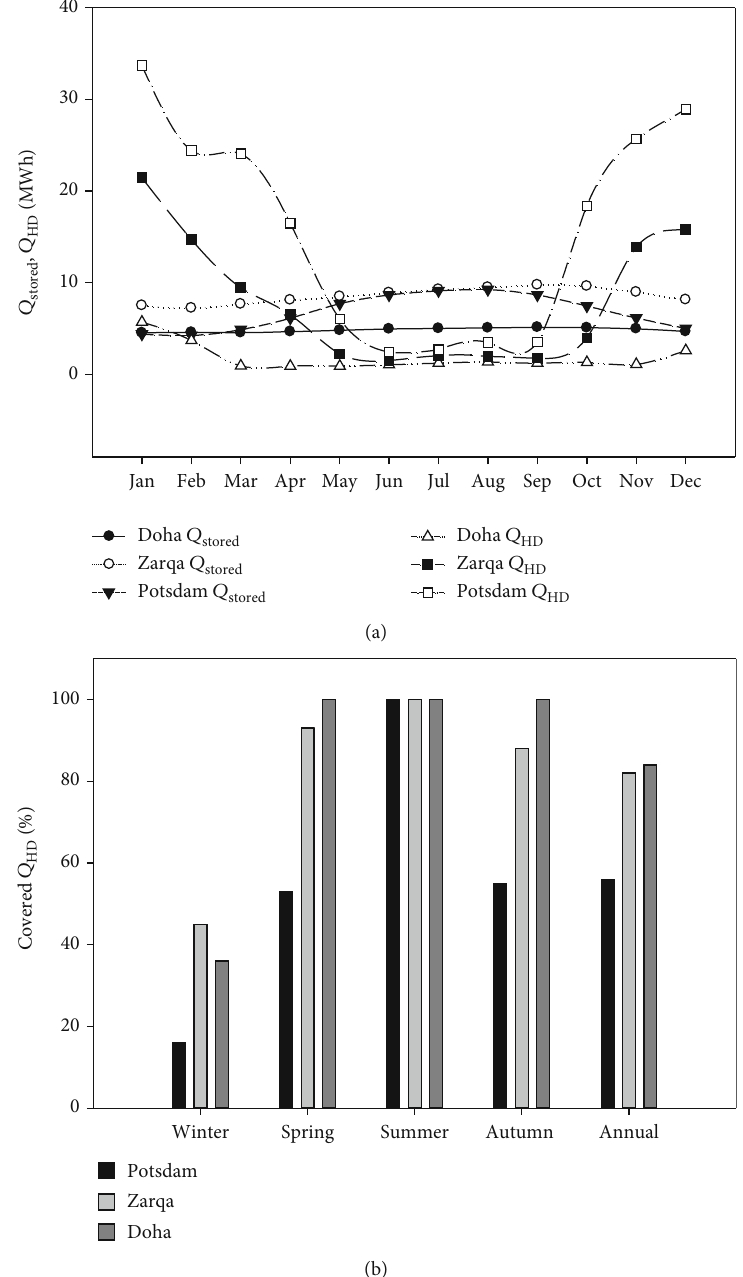
Figure 10: (a) Best results of stored solar thermal energy versus the buildings ’ heat demand for the three selected cities and (b) percentage of seasonal and annual covered heat demand for the same